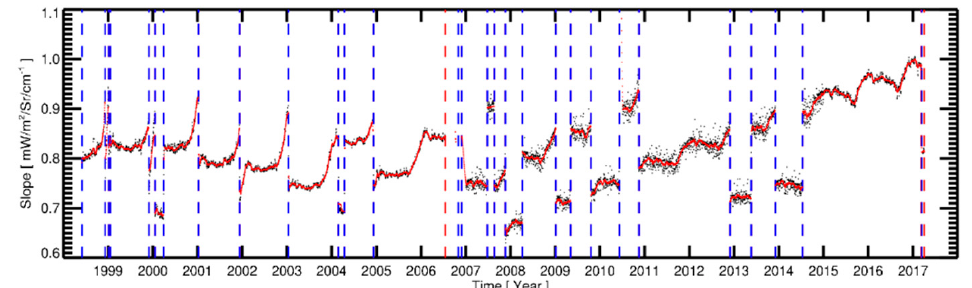
Figure 7. Time series of calibration slope for Meteosat-7 IR channel. Vertical dashed lines represent radiometric events such as gain changes. The vertical dashed red line shows the start of the satellite’s move to the Indian Ocean and also the end of the life time. Black dotted lines represent daily calibration values and the red lines are the smoothed calibration values, which will be used for the recalibration.